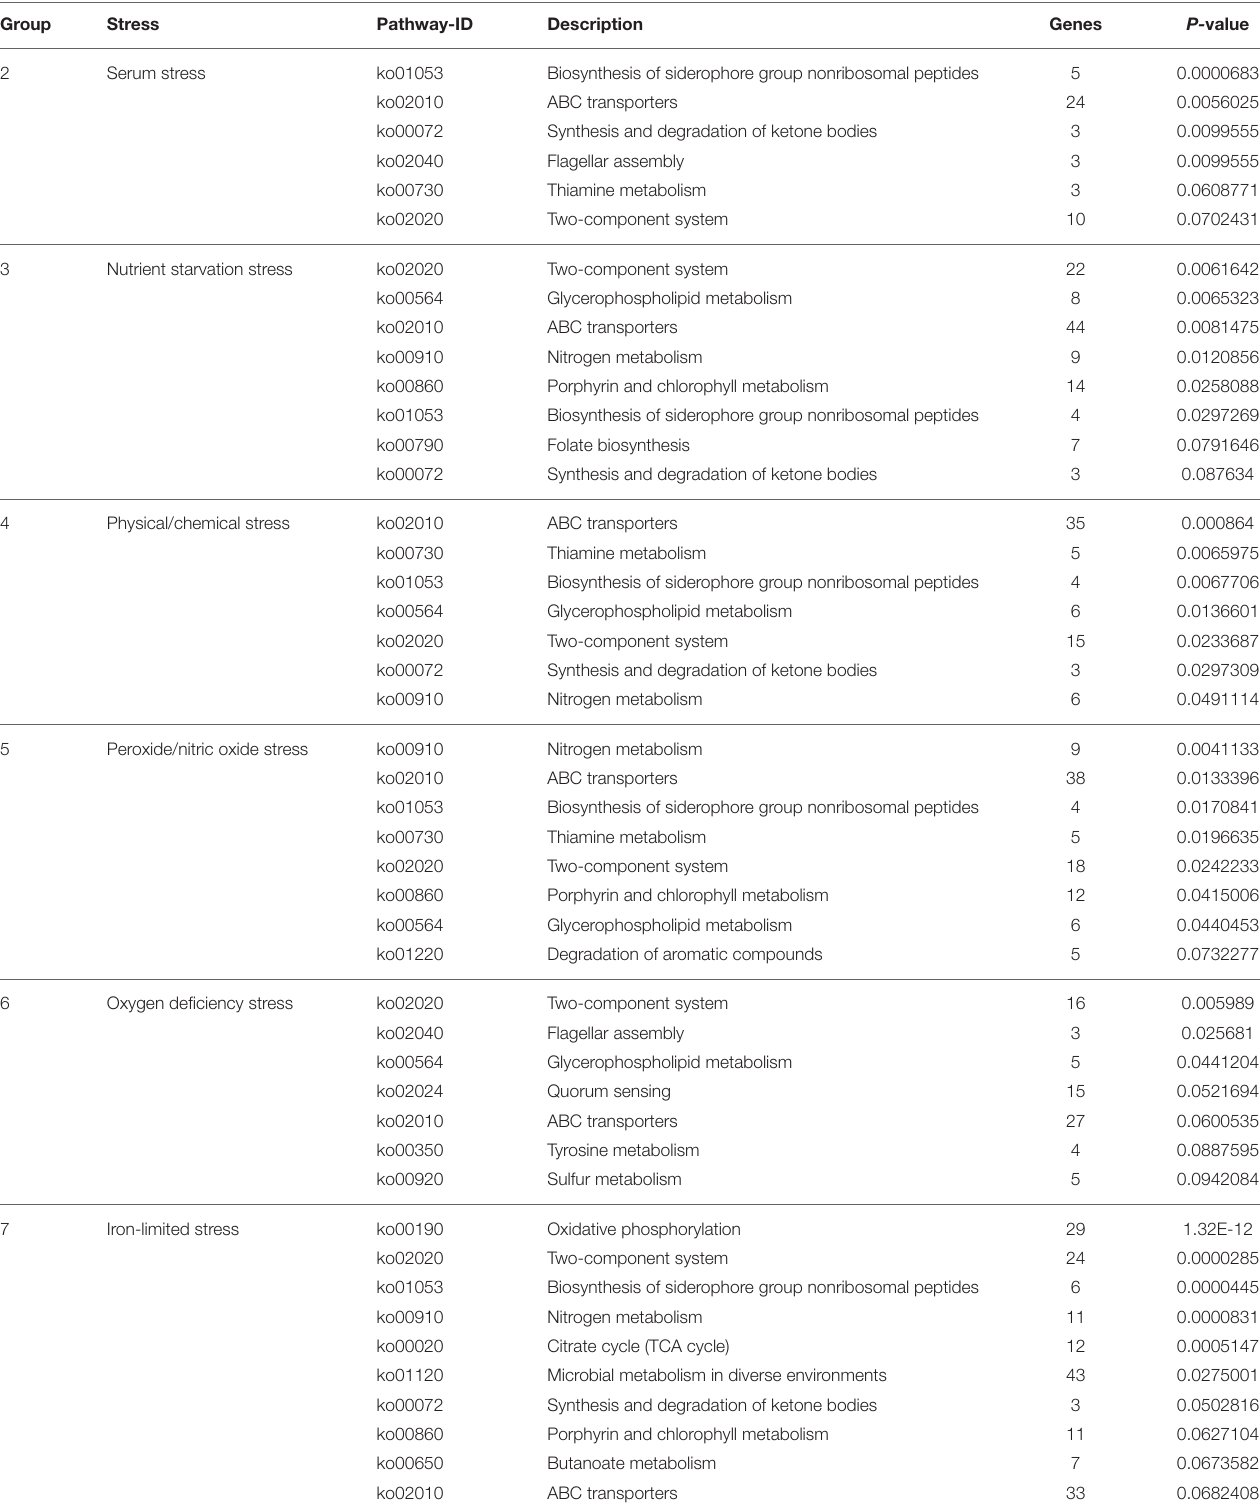
TABLE 3 | KEGG enrichment analysis of DEPs in response to each stress treatment.